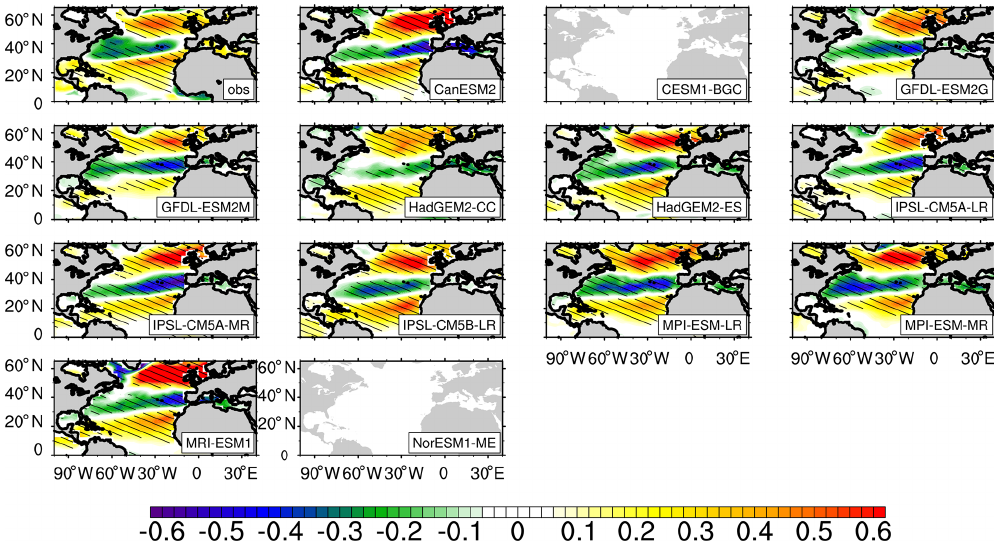
Figure 5. Same as Fig. 4 but for the winter-average sea surface wind speed anomalies against the NAO indices. A missing panel means that the model output is not